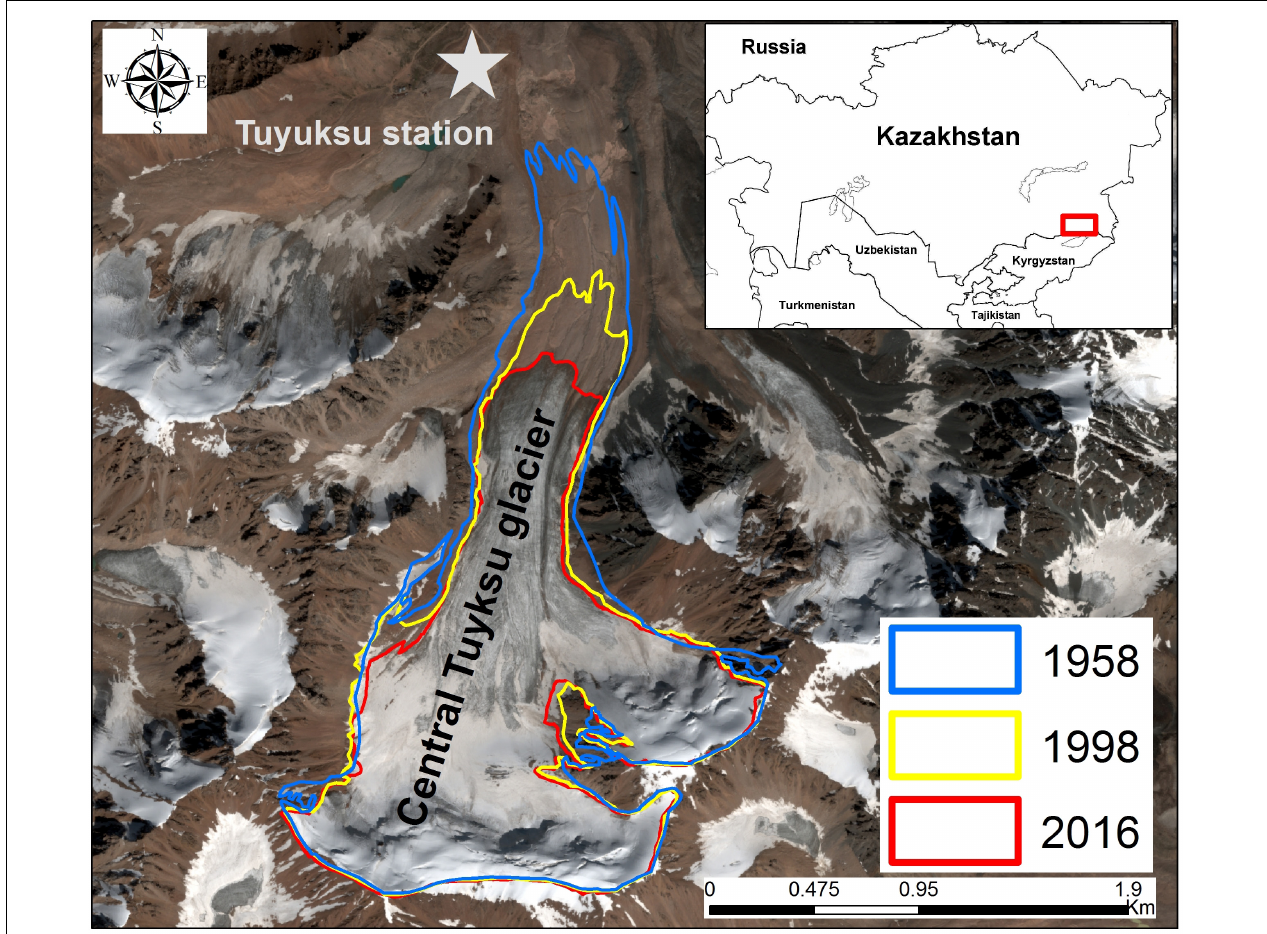
FIGURE 1 | Study area. Outlines of the Central Tuyuksu glacier are shown for 1958, 1998, and 2016. Pléiades image is used as background.